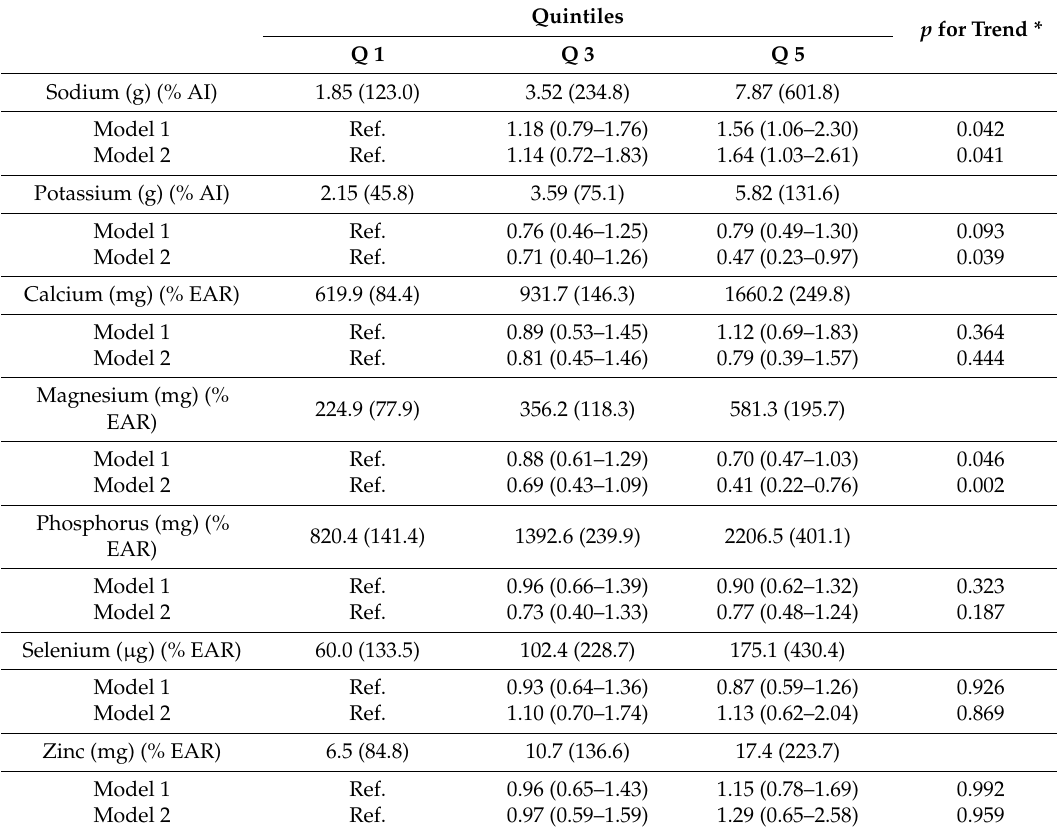
Table 3. Odds ratio (95% confidence interval) for incident chronic kidney disease according to quintiles of mineral